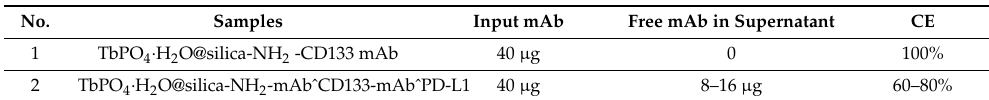
Table 1. The conjugated efficiency of TbPO 4 ·H 2 O@silica-NH 2 nanorods with mAb against CD133 and PD-L1.